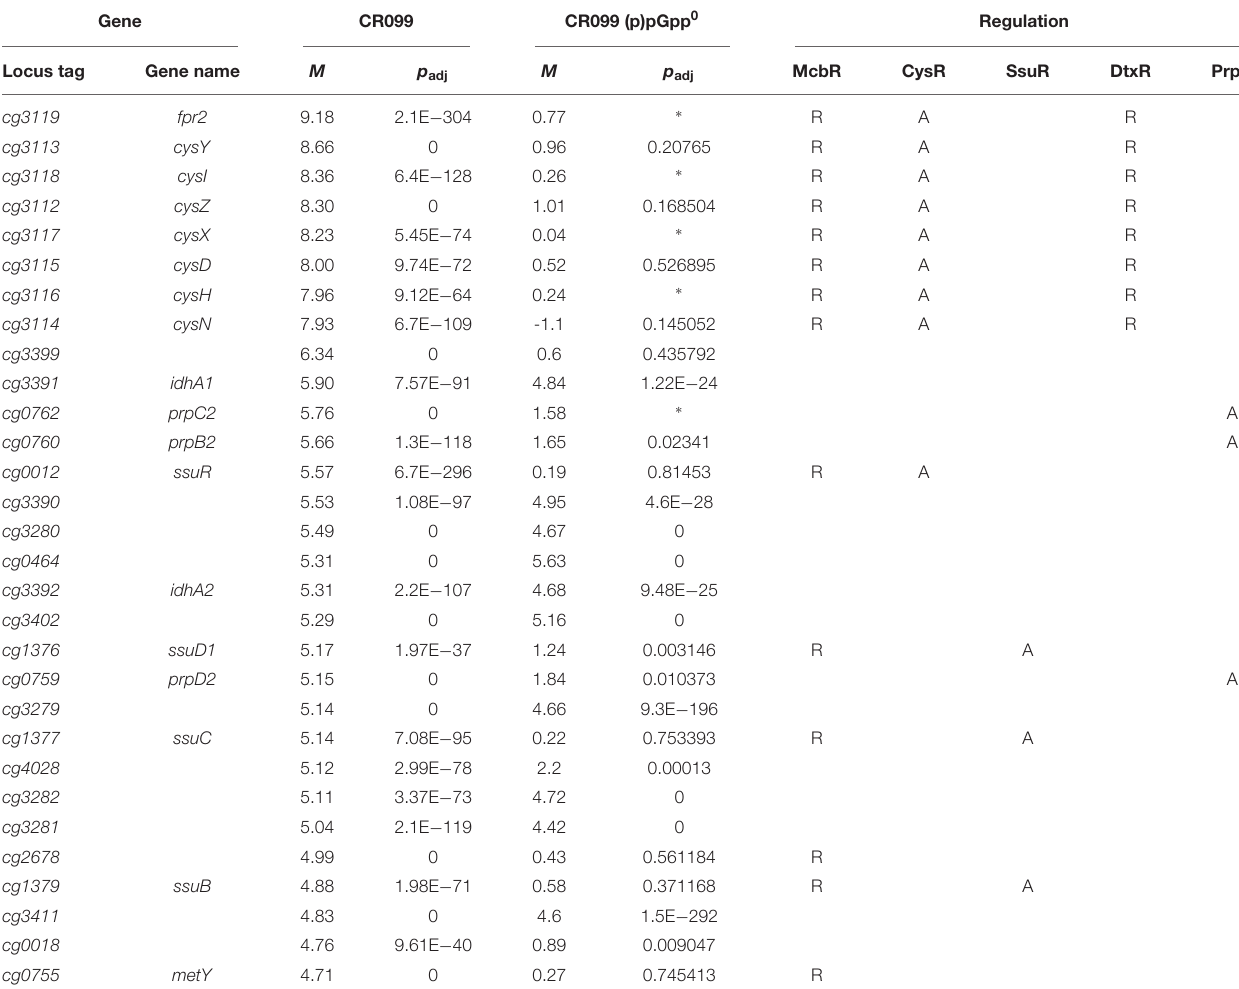
TABLE 4 | Top-scorer analysis of genes characterized by increased transcript levels in the parental strain CR099 after 60 min of stress exposure compared to the unstressed state, as well as their affiliation to the regulons of different regulators of sulfur, iron, and propionate metabolism (A: activator; R: repressor). Gene CR099 CR099 (p)pGpp 0 Regulation Locus